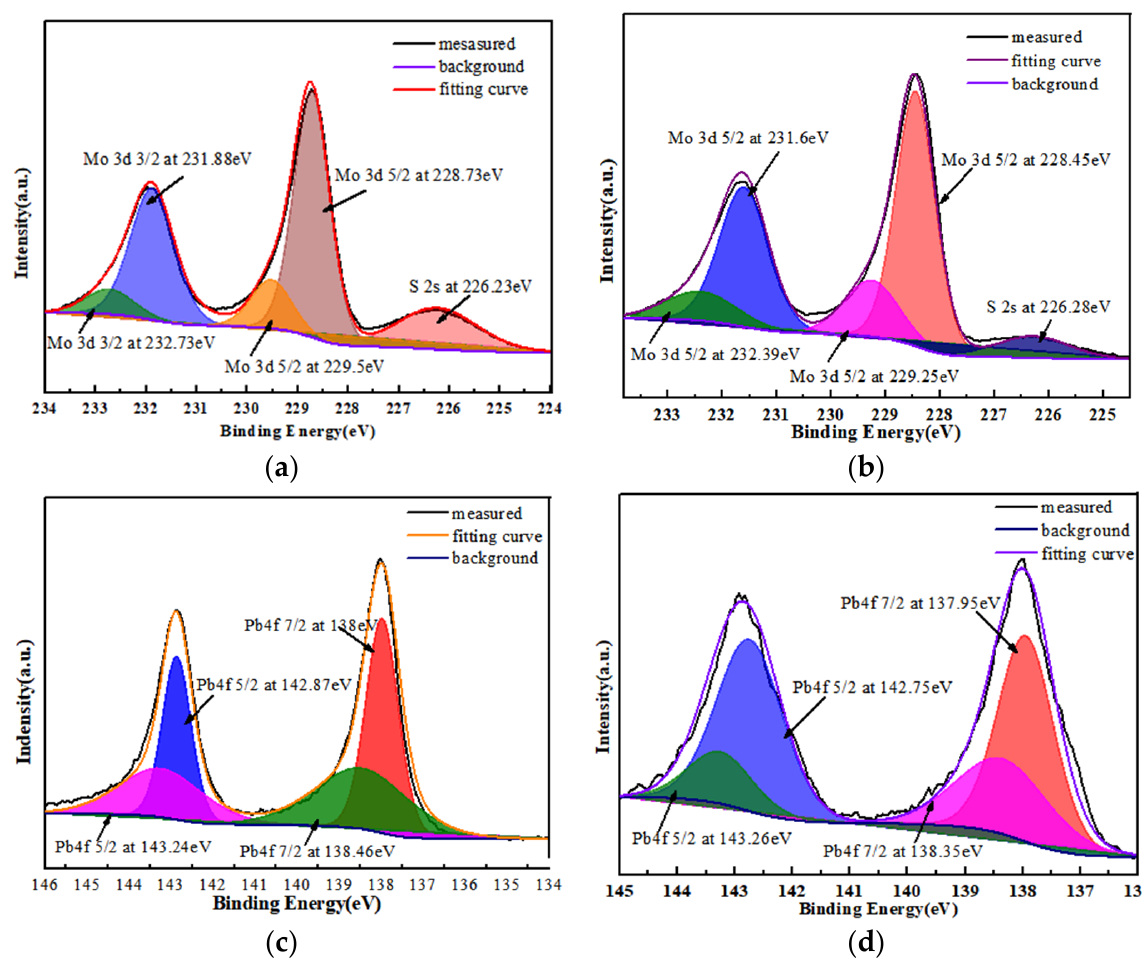
Figure 3. XPS of Mo/MoS 2 -Pb-PbS composite films before and after UV radiation. ( a ) Mo3d without UV radiation; ( b ) Mo3d after 40h UV radiation; ( c ) Pb4f-UV without UV radiation; ( d ) Pb4f-UV after 40h UV radiation.